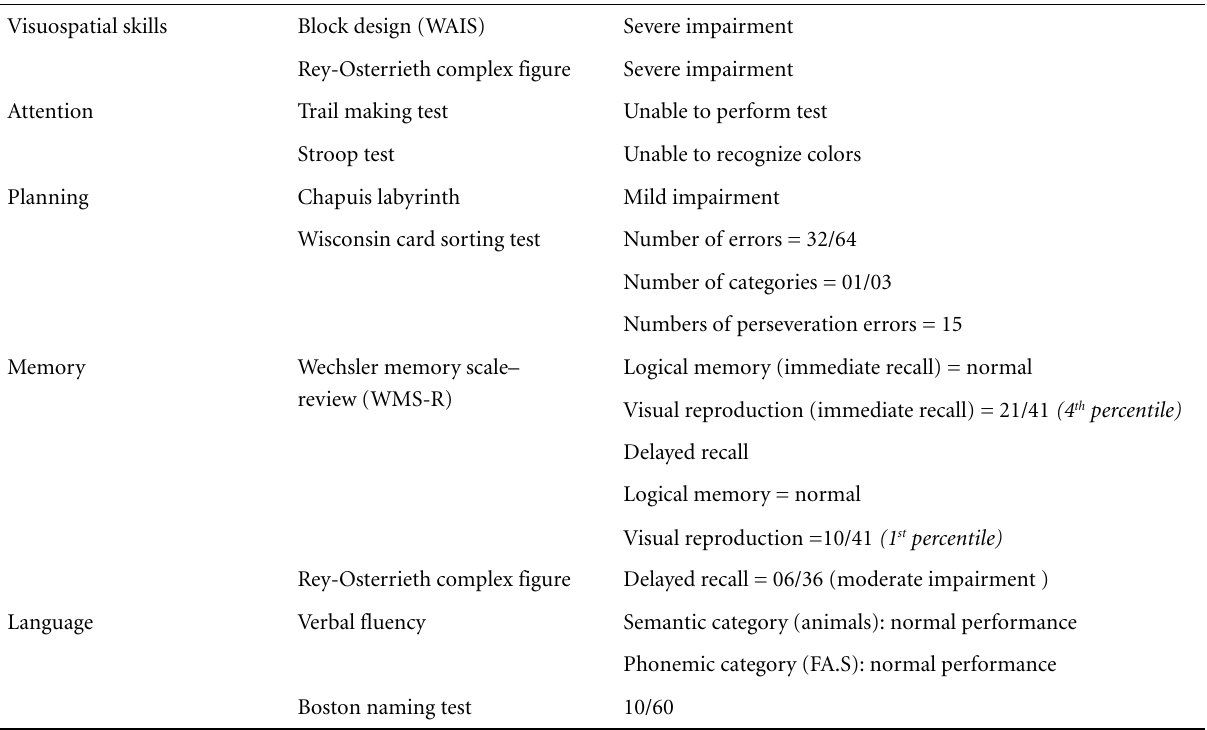
Table 2. Neuropsychological testing: attention, executive functions, memory, language and visuospatial skills. Visuospatial